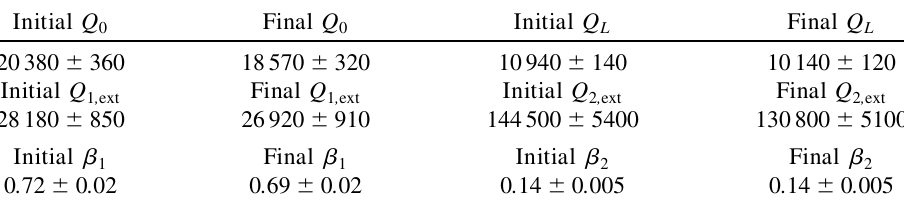
TABLE X. Cavity Q measurements of TE mode of cavity 1 using a HP8510C network 012 analyzer before and after the second high-power test. The resonant frequency is 17.850 GHz.